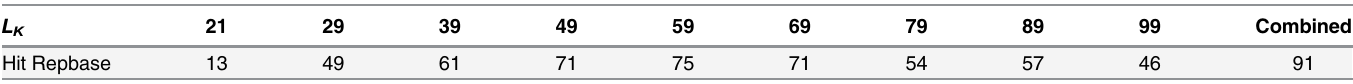
Table 9. The number of repeats in Repbase that match (over the minimum threshold 0.85) one de novo repeat for different k-mer length L K . By default, REPdenovo use different k-mer length (29, 39, and 49) together, and its result is marked as “ Combined ”